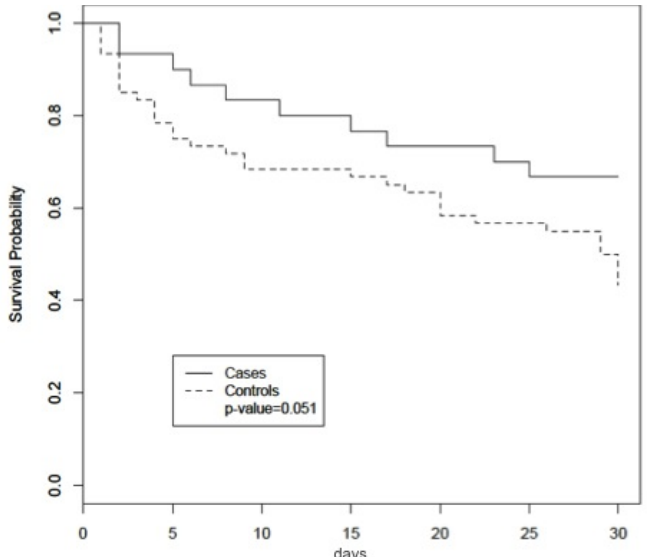
Figure 2. Overall 30-day survival rate in patients with carbapenem-resistant K. pneumoniae or A. baumannii septic shock receiving antibiotics plus intravenous NAC (cases, n = 30) or antibiotics only (controls, n = 60). Table 2. Indipendent risk factors for 30-day mortality of patients with septic shock caused by carbapenem-resistant Klebsiella pneumoniae and Acinetobacter baumannii .